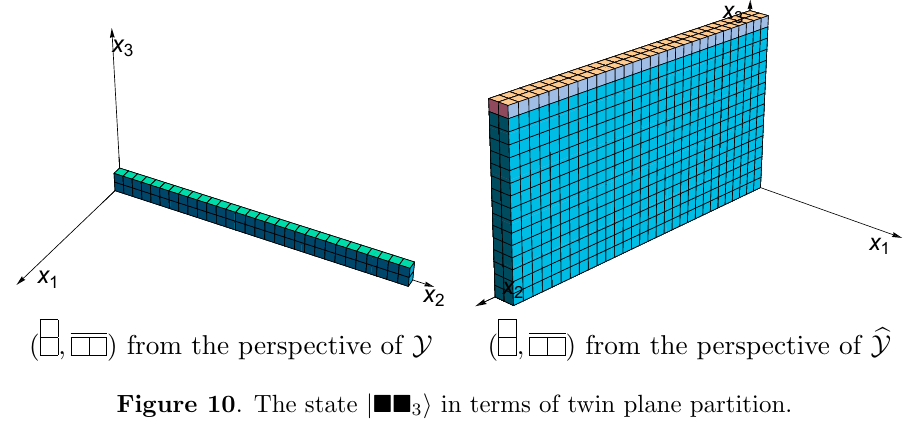
(cid:4)(cid:4) 3 i in terms of twin plane partition. j